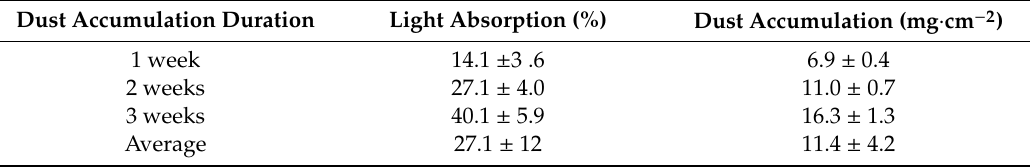
Table 2. Light absorption by accumulated dust and weight of accumulated poultry dust on TiO 2 . Dust Accumulation